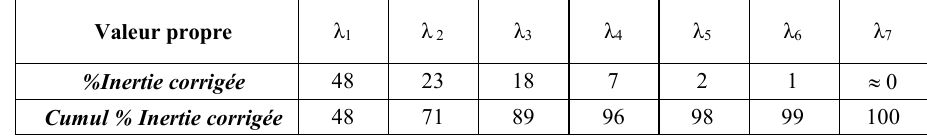
Tableau 4. Pourcentages d’inerties corrigées (benzécriennes) et leurs cumuls. Valeur propre λ 1 λ 2 λ 3 λ 4 λ 5 λ 6 λ 7 %Inertie corrigée 48 23 18 7 2 1 ≈ 0 Cumul % Inertie corrigée 48 71 89 96 98 99